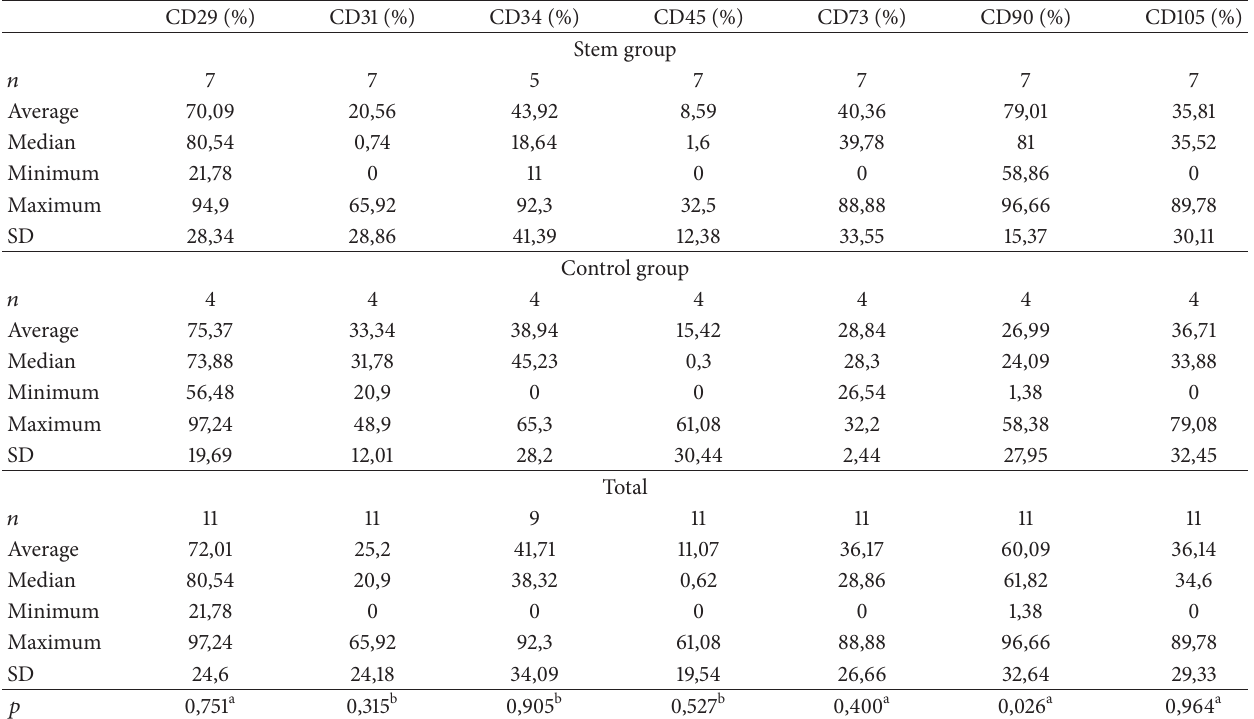
Table 3: Surface markers expression in both groups (SG and